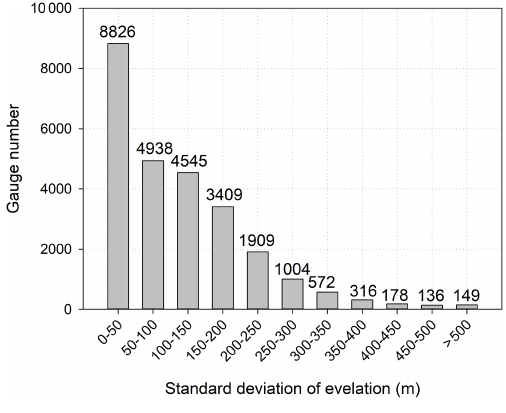
Figure 9. Number of gauges in each topography